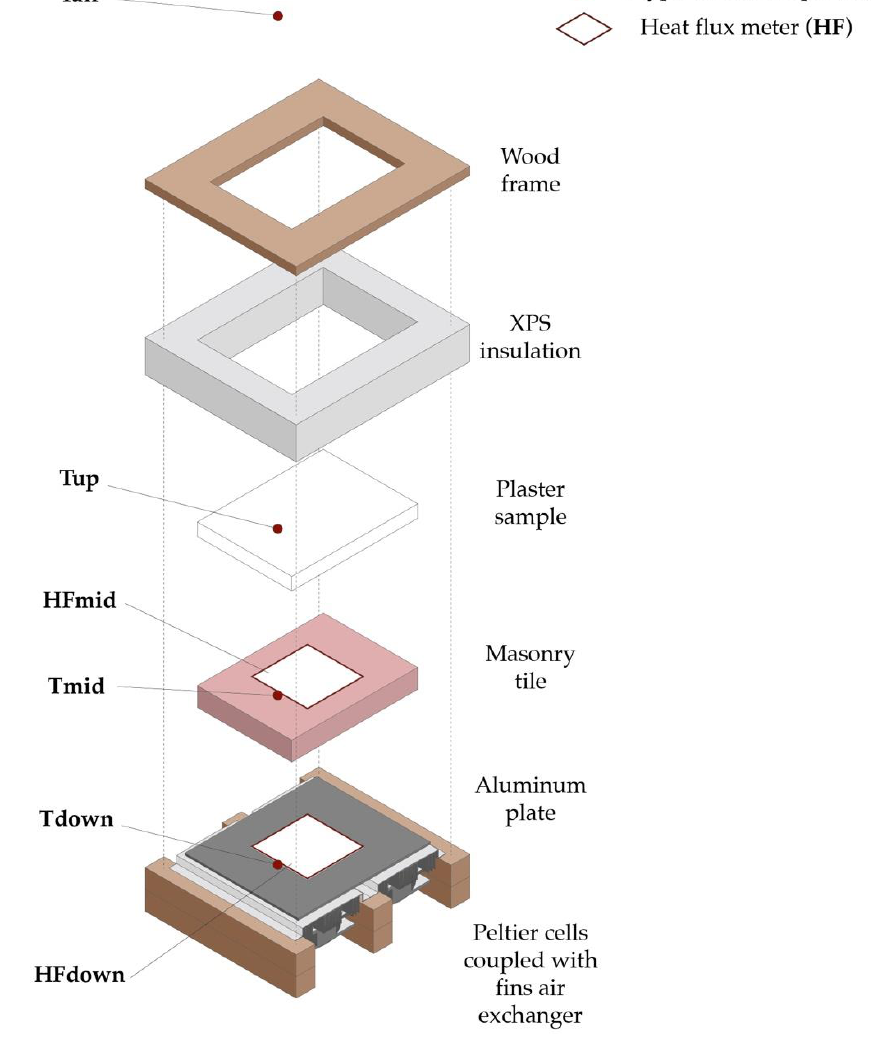
Figure 2. Experimental set up and sensors’ position. Table 1. Uncertainties of the sensors used.